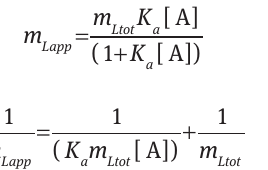
Figure 7B. The values of K a single-site system by either employing nonlinear regres- sion with Equation (1) or by using linear regression with Equation (2) (Hage